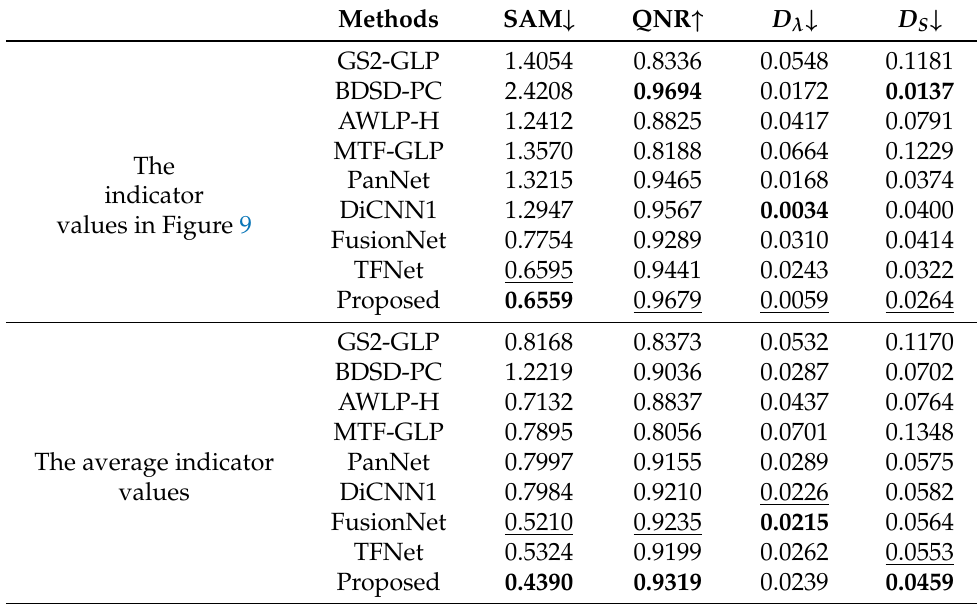
Table 10. Comparison of indicator evaluation results on the full-resolution GeoEye-1 dataset.